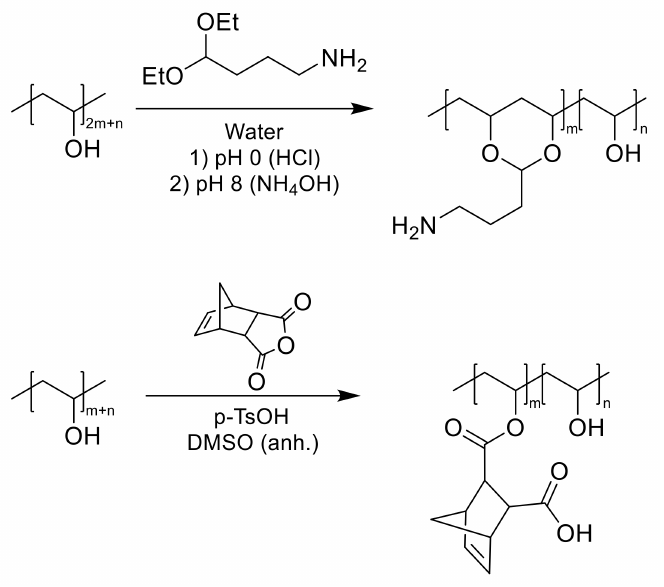
Figure 7. Schematic representation of the modification of poly(vinyl alcohol) (PVA) with amine groups ( top ) and 2-norbornene groups ( bottom